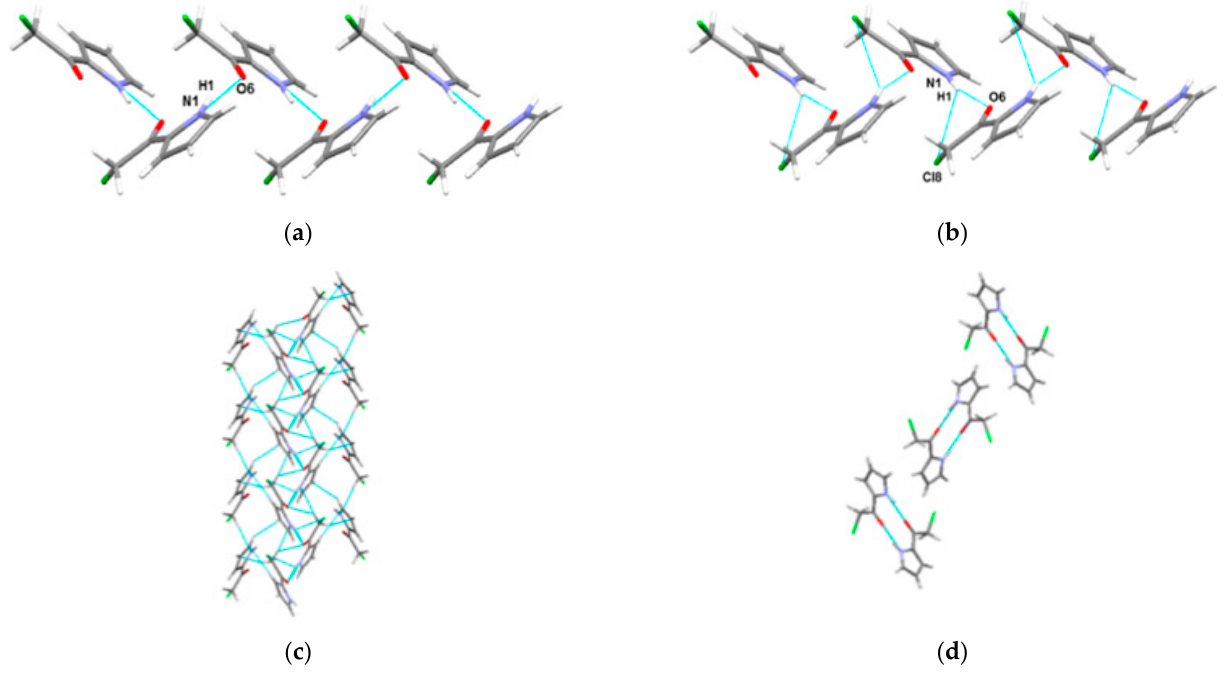
Figure 5. Molecular arrangements in structure II . ( a ) The c -axis view of the chain created by the hydrogen bond N1-H1 ⋯ O6 and ( b ) stabilized by the hydrogen bonds N1-H1 ⋯ Cl8 and C4-H4 ⋯ O6. H-bond parameters [N1-H1 ⋯ O6] N1-H1 0.90(2)Å, H1 ⋯ O6(1/2+x,1/2-y,1-z) 2.05(2)Å, <N1H1O6 164(1)°, [C4-H4 ⋯ O6] C4-H4 0.93(2)Å, H4 ⋯ O6(3/2-x,1-y, − 1/2+z) 2.52(2)Å, <C4H4O6 163(1)°, [N1-H1 ⋯